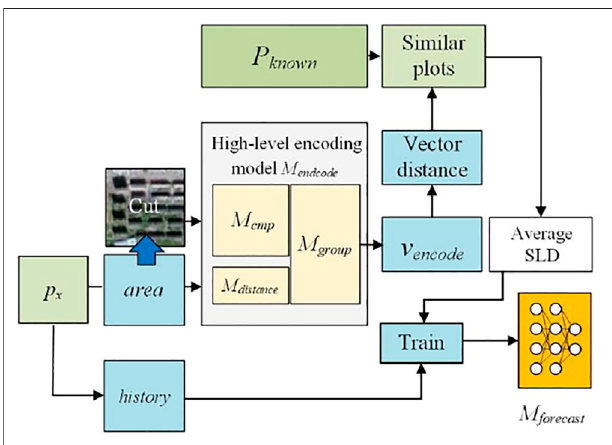
FIGURE 5 | M encode and SLF model